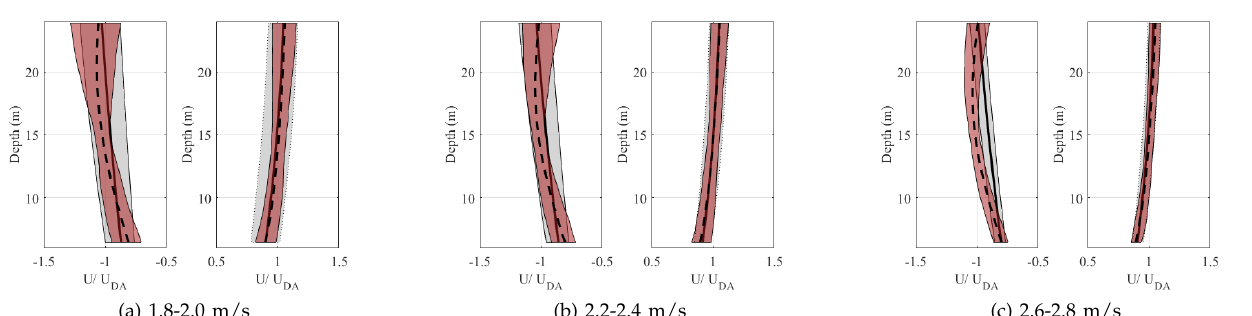
Fig. 5. For the near bed position, a range of shear profiles for three different disk averaged velocities, for varying measured profiles (red band), varying predicted profiles (grey band), mean measured (dashed black) and mean predicted (solid black).